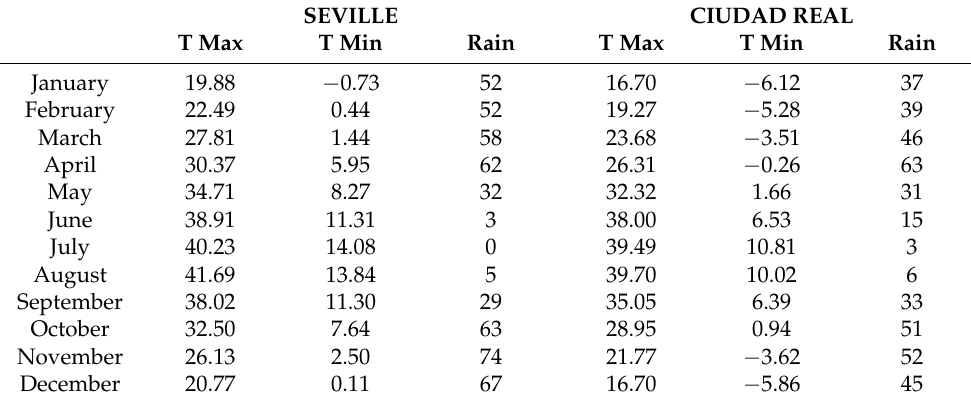
Table 7. Comparison of the two locations where data of the experiments were obtained. Data are the average of monthly data in the period 2006 to 2021. Source of data: Climatic station of “La Rinconada” and “Ciudad Real” of the Spanish Network of agri-climatic stations for irrigation (SIAR, https://eportal.mapa.gob.es/websiar/SeleccionParametrosMap.aspx?dst=1, accessed on 15 October 2022). SEVILLE CIUDAD REAL T Max T Min Rain T Max T Min Rain January 19.88 −